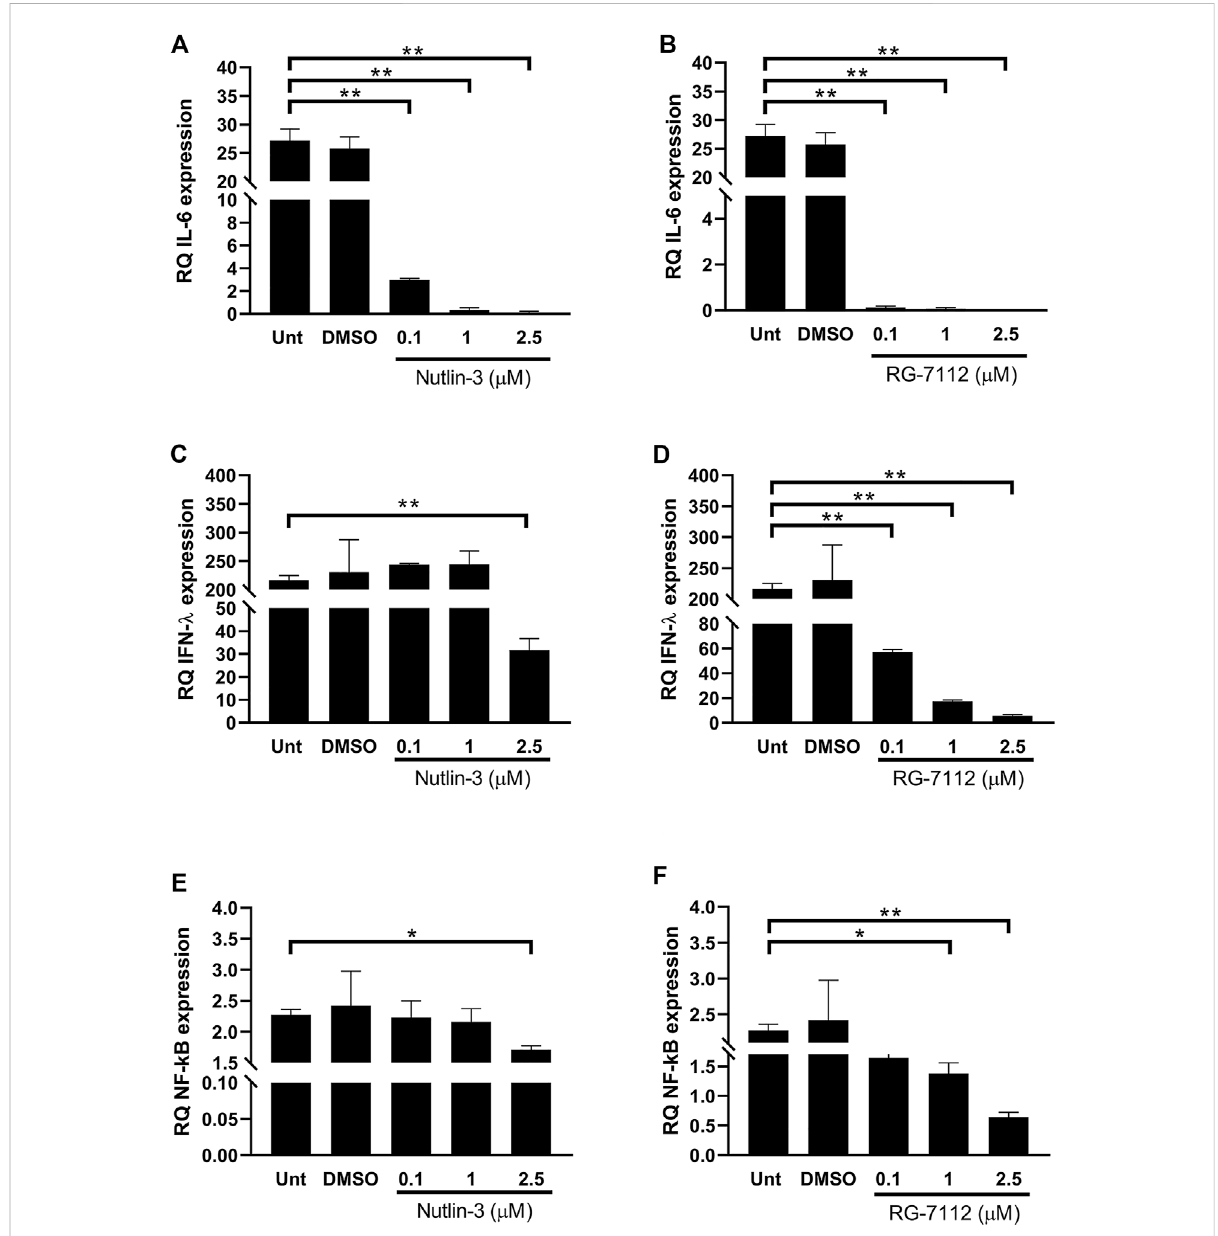
Quanti fi cation of in fl ammatory environment. Relative quanti fi cation (RQ) of expression levels of IL-6 (A,B) and IFN- λ 1 (C,D) and NF- κ B (E,F) , in SARS-CoV-2-infected A549-hACE2 cells treated with different concentrations of Nutlin-3 (A,C,E) or RG-7112 (B,D,F) and relative controls (Unt, untreated; DMSO, control vehicle). Gene expression was normalized to GAPDH housekeeping gene, and quanti fi cation is relative to not infected untreated cells. Mean ± standard error of the mean of two independent experiments in triplicate are shown. Statistical analysis was performed by Student ’ s t test. * p ≤ 0.05; ** p ≤